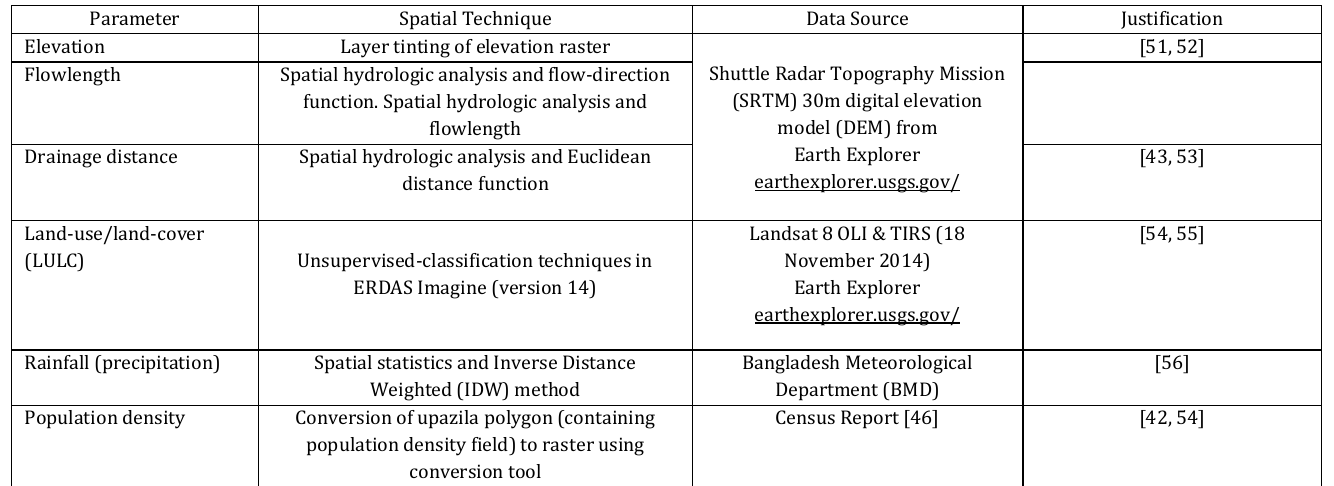
Table 1: Spatial data used in the